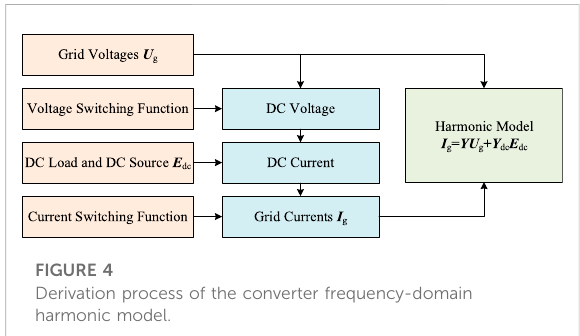
FIGURE 4 Derivation process of the converter frequency-domain harmonic